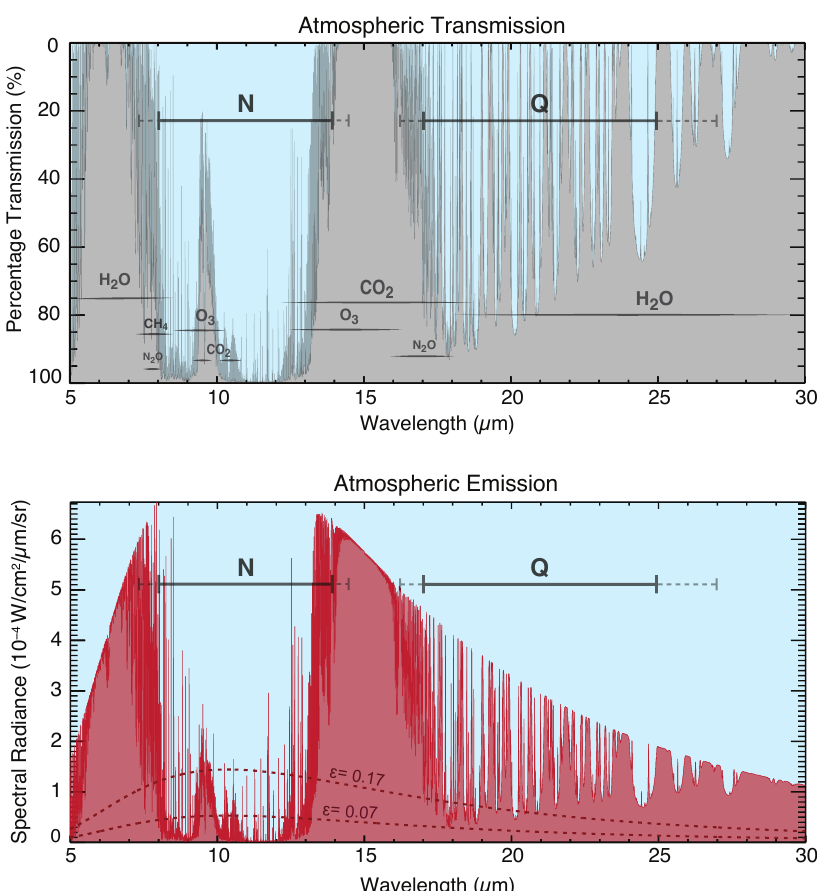
Figure 2. The atmospheric transmission (top) and emission (bottom) in the mid-IR, for conditions at Cerro Paranal, as described in Figure 1. Transmission is indicated by the blue–gray interface varying between 100% (full transmission) and 0% (total attenuation) from the top of the atmosphere down to the surface [5,6]. Emission from the atmosphere is indicated by the red shaded curve, assuming annual average temperatures, 1.5 mm PWV, and an airmass of 1.16. Additional emission from the telescope is shown for two different assumed values of emissivity, spanning typical values found in the literature ( (cid:101) = 0.07–0.17) [31,34,35], and typical ambient temperature of 280 K. The total telluric thermal radiance is orders of magnitude greater than that received from the giant